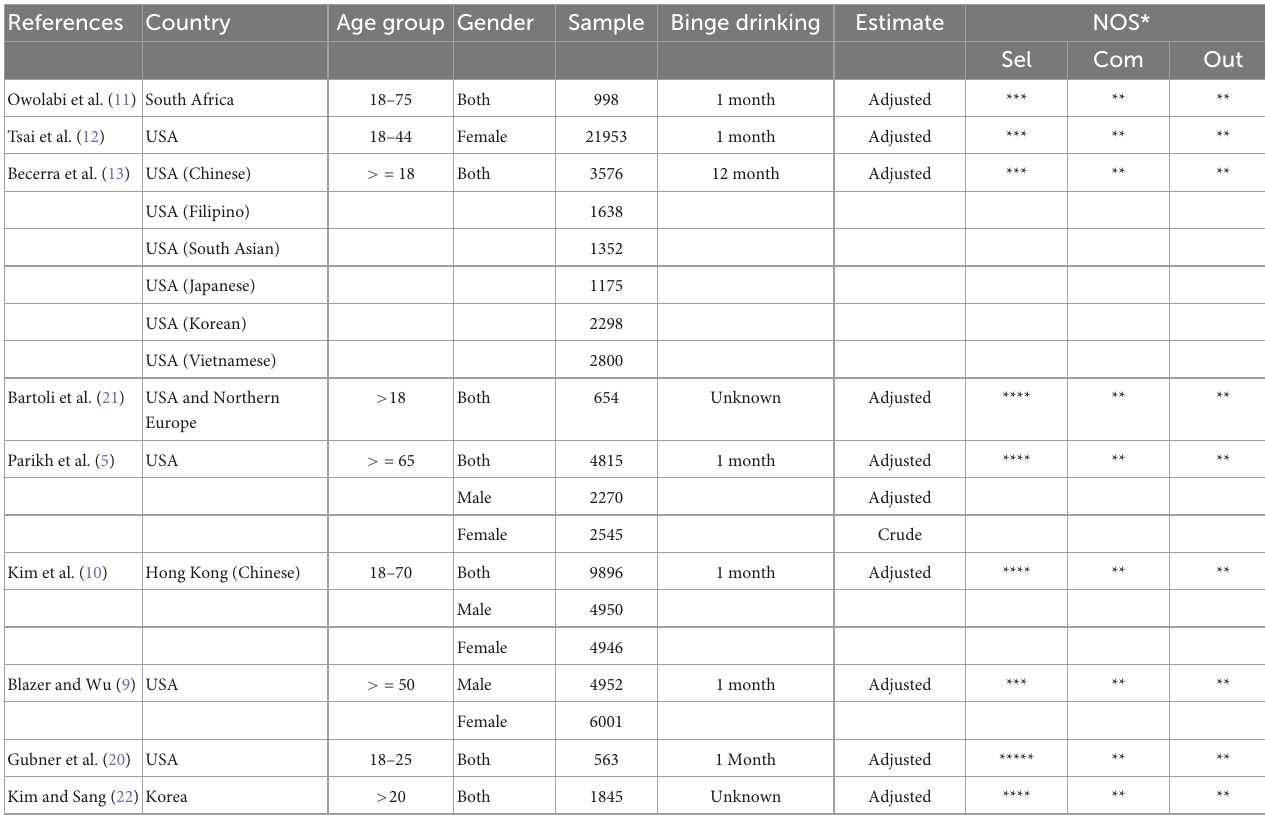
TABLE 1 Summary of studies